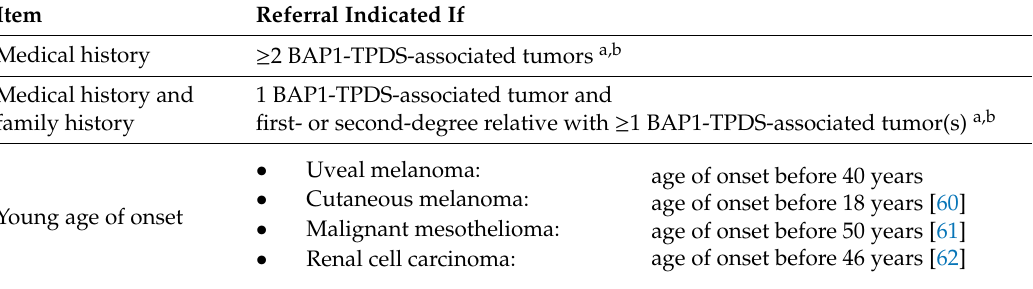
Table 4. Proposed referral guidelines for genetic diagnostics of BAP1-tumor predisposition syndrome